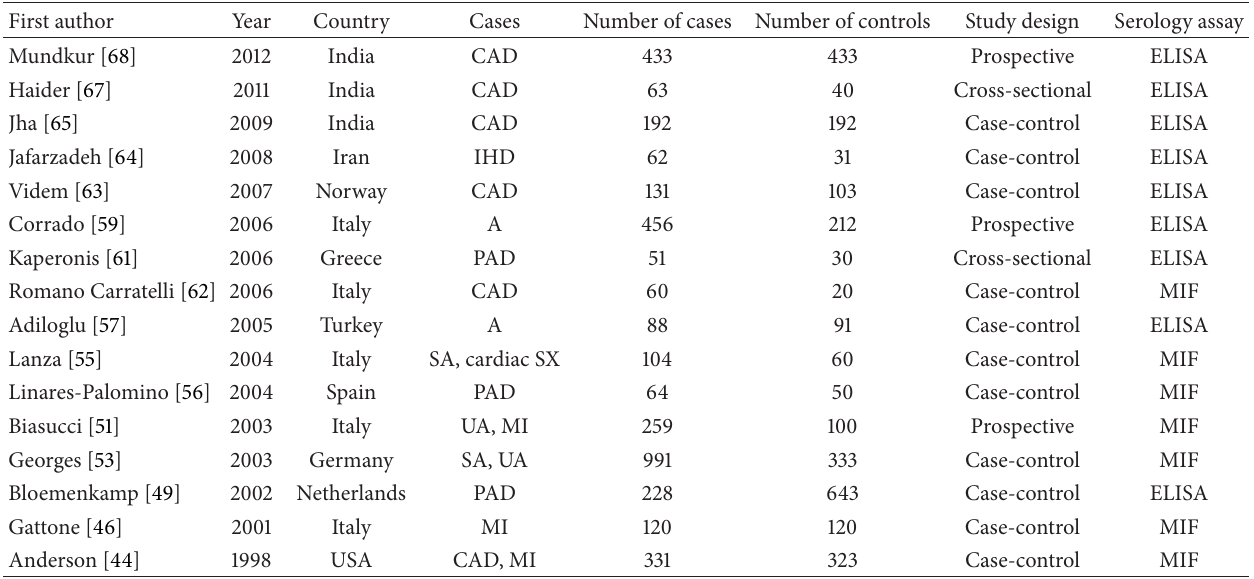
Table 1: Characteristics of the studies included in the case-control analysis.